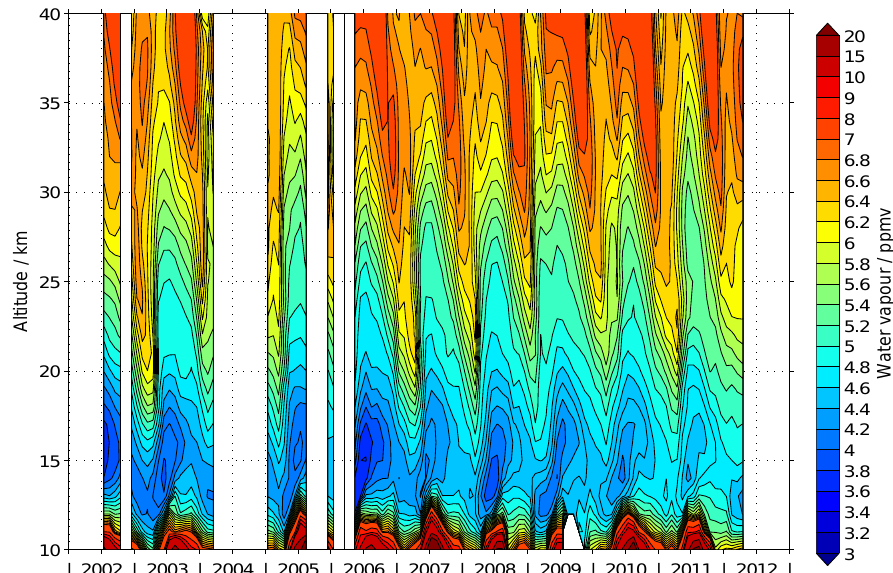
Figure 15. Altitude-time evolution of water vapour in the polar regions (70–90 ◦ N) derived from Envisat/MIPAS observation for the time period